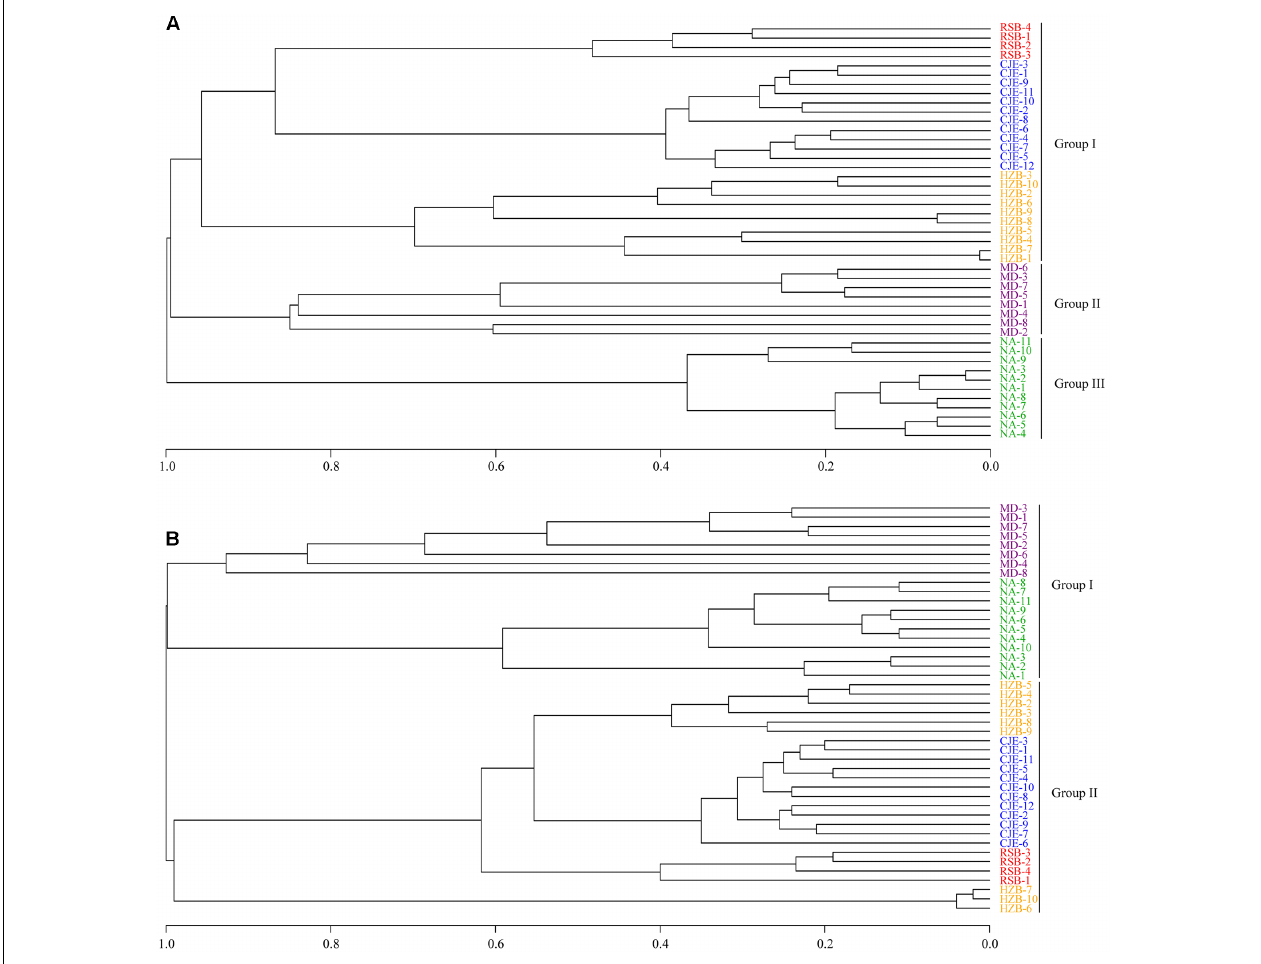
FIGURE 9 | UPGMA clustering of AOA (A) and AOB (B) community compositions in previous studies and in the present study. RSB- ∗ , CJE- ∗ , HZB- ∗ , MD- ∗ , and NA- ∗ indicate sequences from this study, Changjiang Estuary (Xia et al., 2015), Hangzhou Bay (Zhang et al., 2015, 2016), Minami-Daito Island (Hayashi et al., 2015) and Ny-Ålesund (Tago et al., 2015),